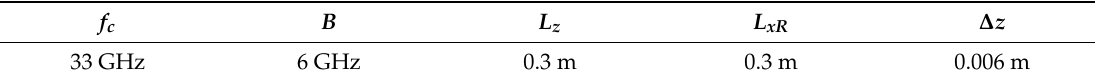
Table 1. Parameters configuration.